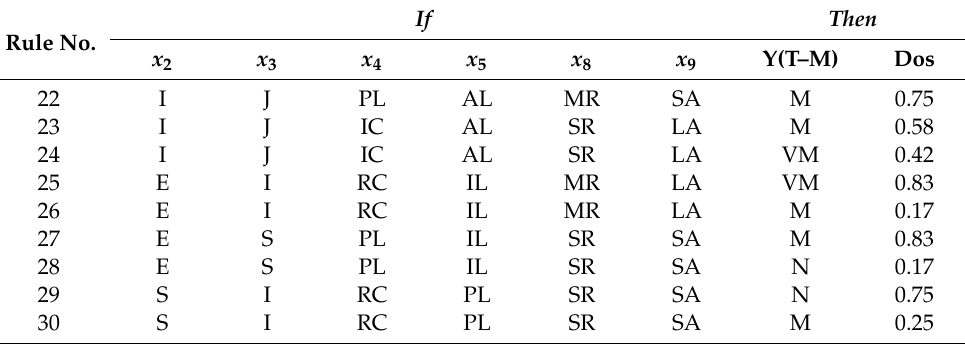
Table 5. The fuzzy rules No.22–No.30 of GRA–Fuzzy logic sub-model of form design sub-elements. Rule